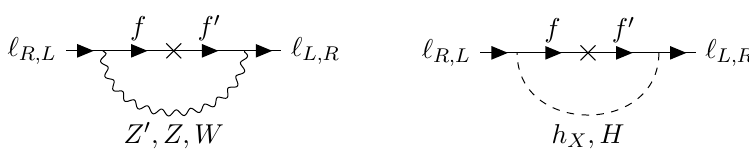
Figure 1 . Illustrative Feynman diagrams for the one-loop contributions to ( g (cid:0) 2) e;(cid:22) induced by the new states and couplings (with a possible mass insertion inside the loop or at an external